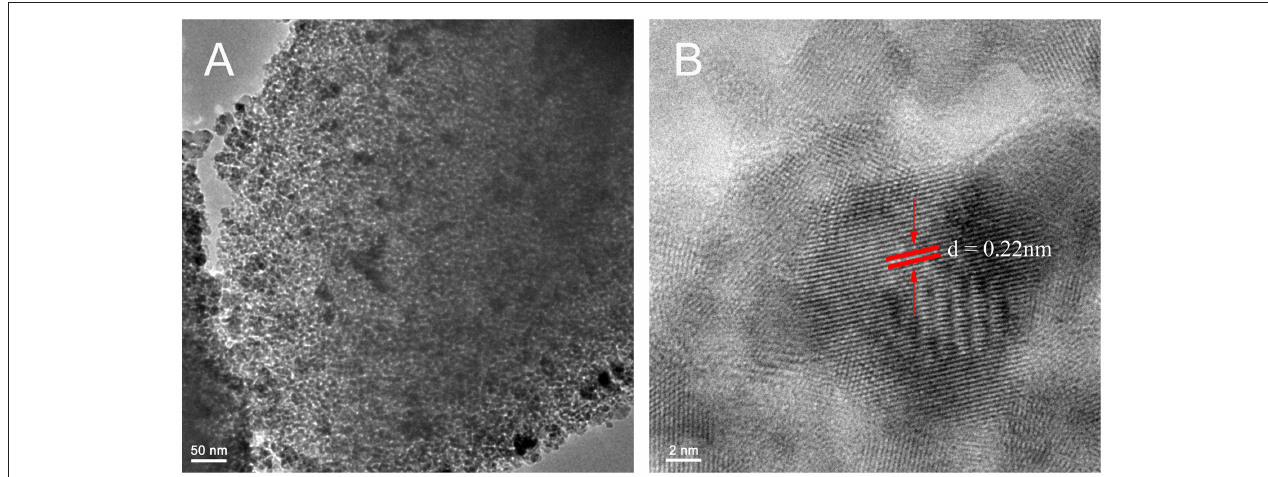
FIGURE 2 | (A) Representative TEM image (low magnification) for as-prepared C, N-TiO 2 . (B) Representative TEM image (high magnification) for as-prepared C, N-TiO 2 . The distance between the lattice fringes (red parallel lines) pointed by the red arrows is 0.22nm.